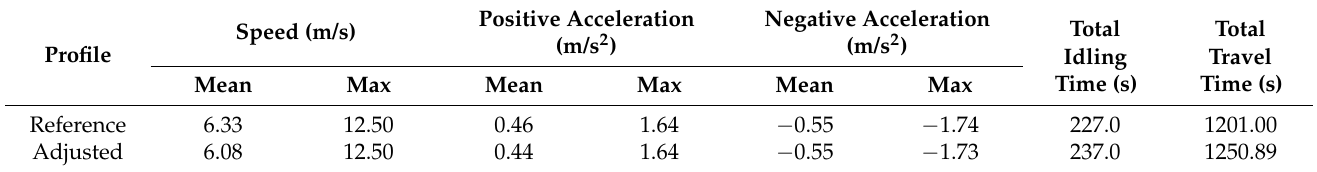
Figure 17. Energy consumption under reference and adjusted speed profiles for the Lisbon case. Table 11. Kinetic summary statistics under reference and adjusted speed profiles for the Lisbon case.